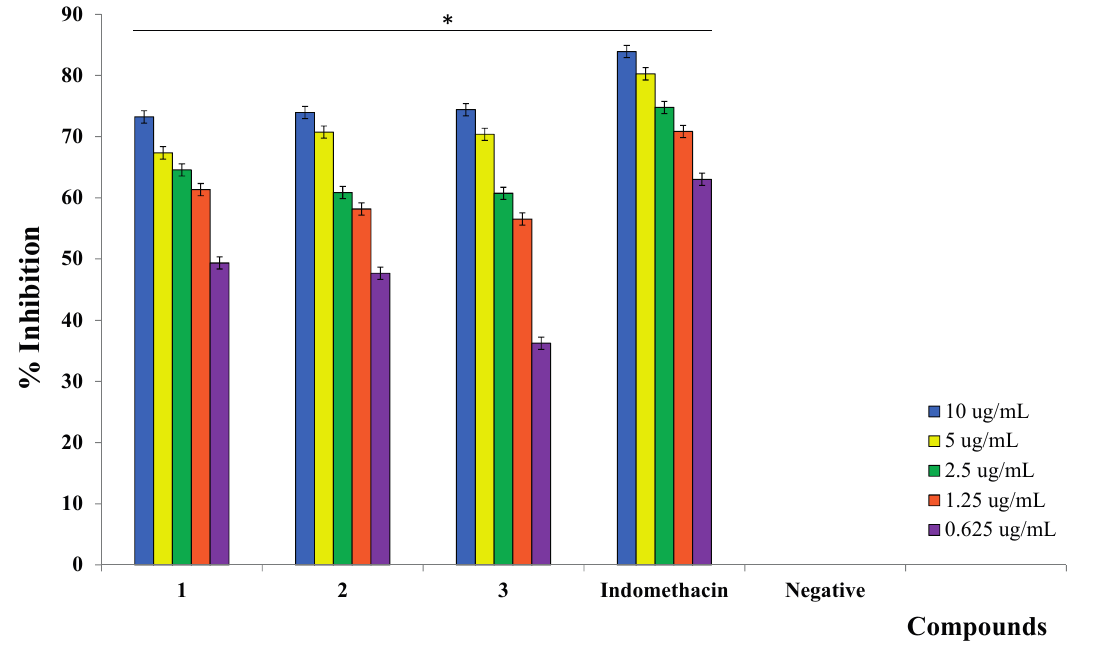
Figure 3. Inhibitory effects of compounds 1 , 2 , and 3 on PGE 2 production by LPS-stimulated human whole blood at various concentrations (value given in mean ± SD; n = 3; * p <